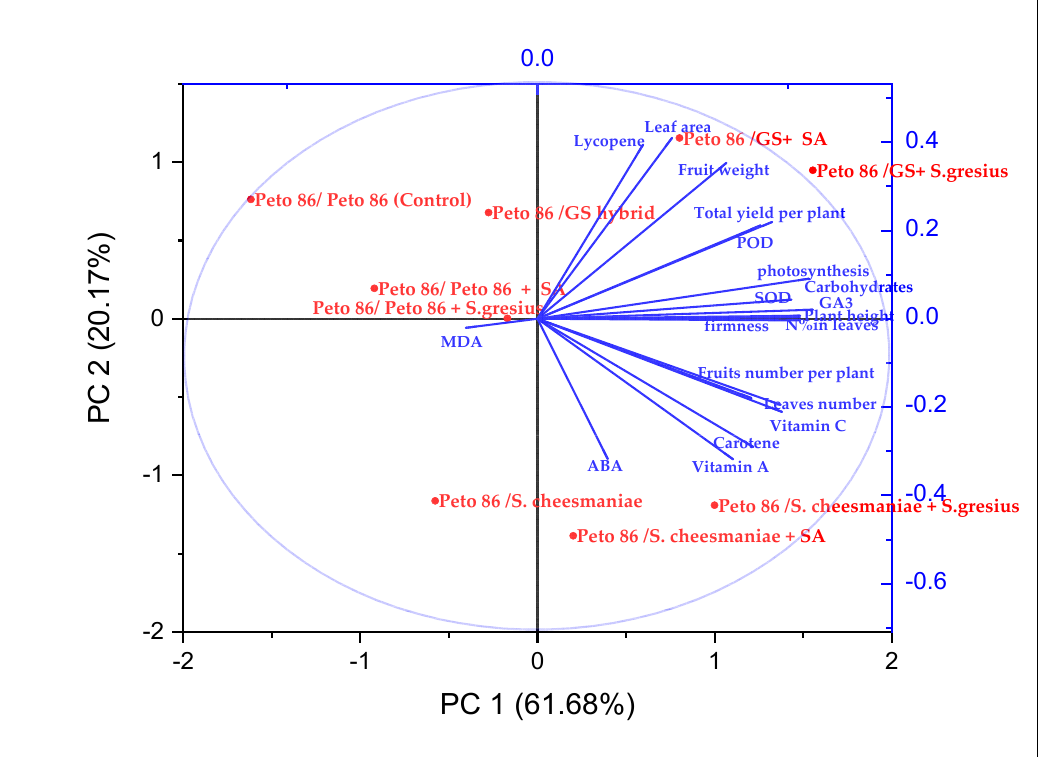
Figure 6. Biplot of the principal components for plant growth, total yield, and physiochemical at- tributes of tomato plants. The plant growth parameters comprise leaf number per plant, plant height, and leaf area. The yield parameters include number of fruits per plant, fruit weight and total yield per plant. The fruit quality attributes include firmness, vitamin C, vitamin A, lycopene content, carotene, total carbohydrates, and total phenol. The physiological parameters include photosynthe- sis and stomatal conductance. The physiochemical parameters comprise SOD, POD, GA3, MDA, and ABA. Red circle symbols signify the nine treatments: self-grafted Peto 86/Peto 86 (control), Peto 86/ S. cheesmaniae , Peto 86/GS hybrid, Peto 86/Peto 86 + SA, Peto 86/ S. cheesmaniae + SA, Peto 86/GS hybrid + SA, Peto 86/Peto 86 + S. griseus, Peto 86 / S. cheesmaniae + S. griseus, and Peto 86/GS hybrid + S. griseus.